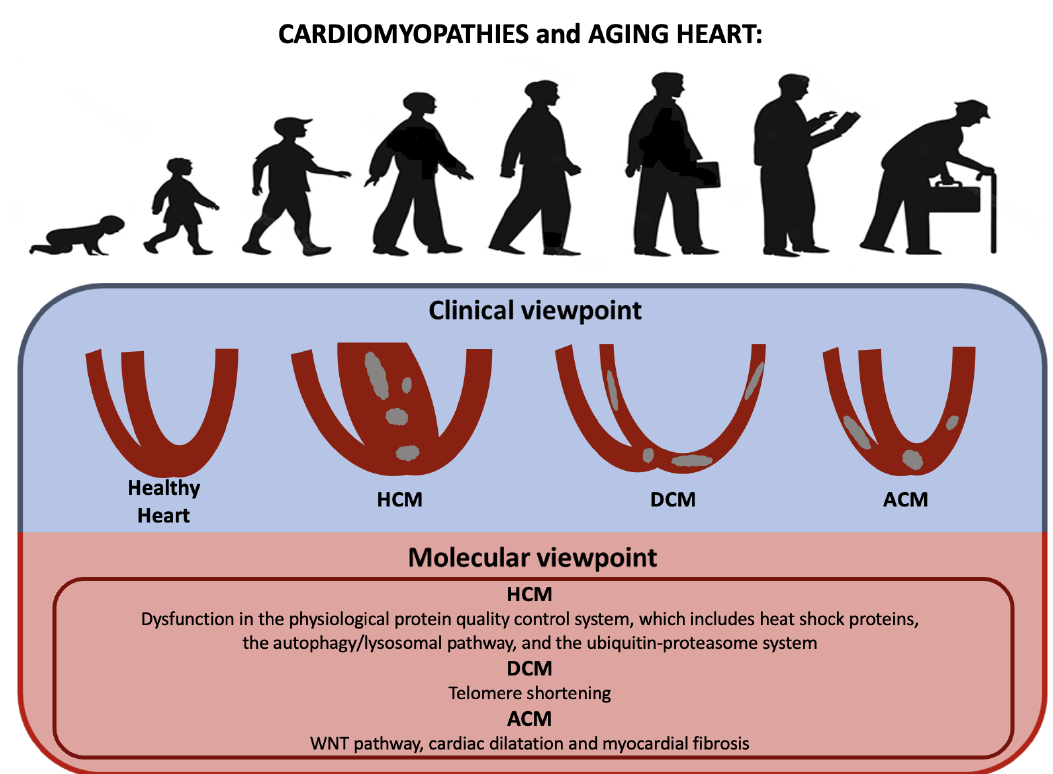
Figure 6. Aging heart and cardiomyopathies: from clinical to molecular viewpoint. Primary cardiomyopathies may be diagnosed even in older people and show specific age-related features.